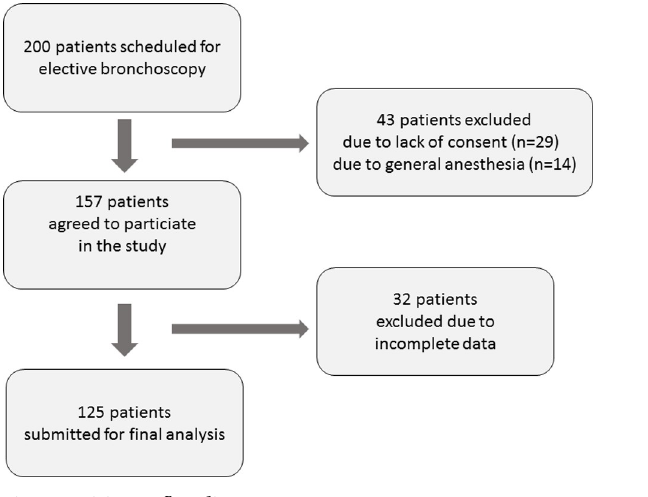
Subjective satisfaction with bronchoscopy was estimated as good by most patients (Fig 2). The median VAS satisfaction rating was 1 cm (IQR 0–4). Thirty-nine patients (31%) declared absolute satisfaction with their procedure (VAS 0/10), while 17 patients (14%) were unsatisfied (VAS > 5/10). The vast majority of patients (n = 113, 90%) declared unconditional consent for future bronchoscopy (rho = 0.404, p < 0.0001). We did not find a difference in satisfaction after